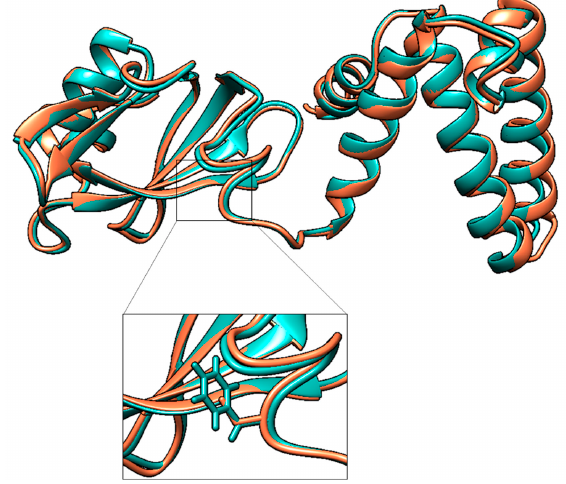
Figure 6. Prediction of the three-dimensional structure of E. coli FB181 HisIE protein (in cyan) superimposed on the three-dimensional structure of wild-type E. coli K12 HisIE available on the AlphaFold2 Protein Structure Database (accession number P06989) (in pink).